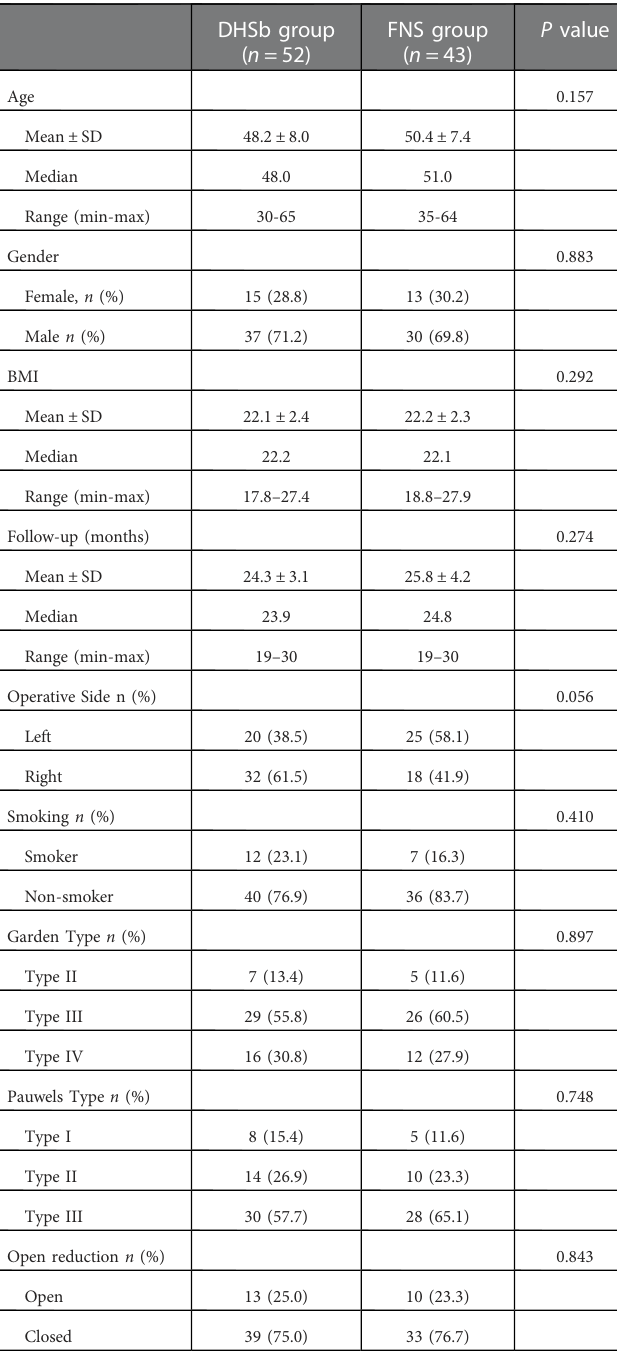
TABLE 1 Summary of patients ’ demographics.